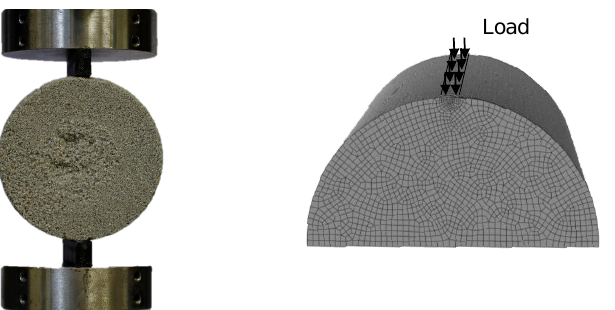
Figure 8. Brazilian test setup. To accurately describe the contact surface the Brazilian test was adapted with polymer supports with a circular contact surface ( left ). This load was modelled with a surface pressure in a symmetrical finite element model (FEM) model ( right